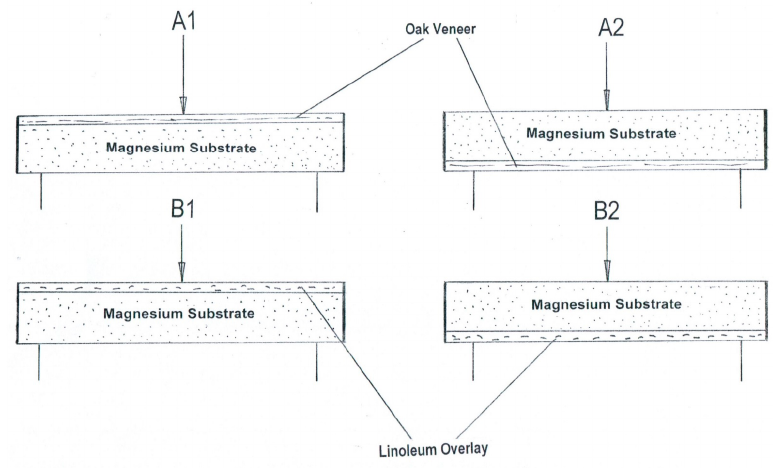
Figure 2. Schematics of the samples based on loading direction.